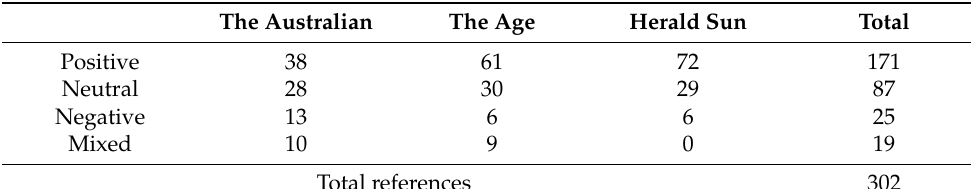
Table 11. Common Religion—tone of references across the